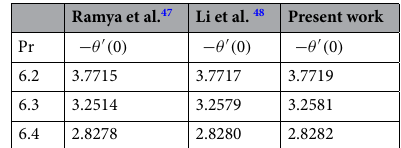
Table 4. The numerical validations for varying Pr on − θ ′ ( 0 ) in limiting case